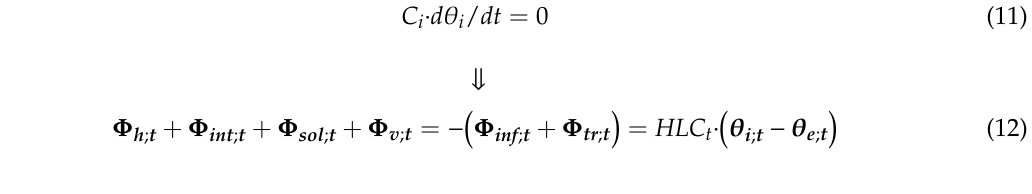
Table 3. Overview of the model equations evaluated by the four data analysis methods. The Linear Regression Analysis (LR), energy signature method (ES), and AutoRegressive with eXogenous input (ARX) models consider vectors, as indicated by the notation in